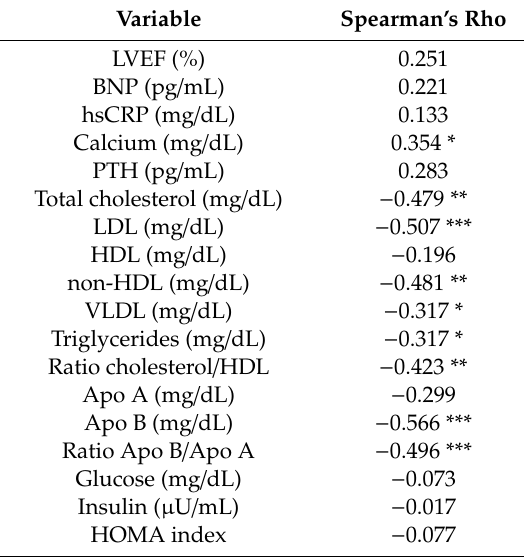
Table 6. Association of serum 25(OH)D levels with biochemical and metabolic parameters in patients with heart failure for the 12-month